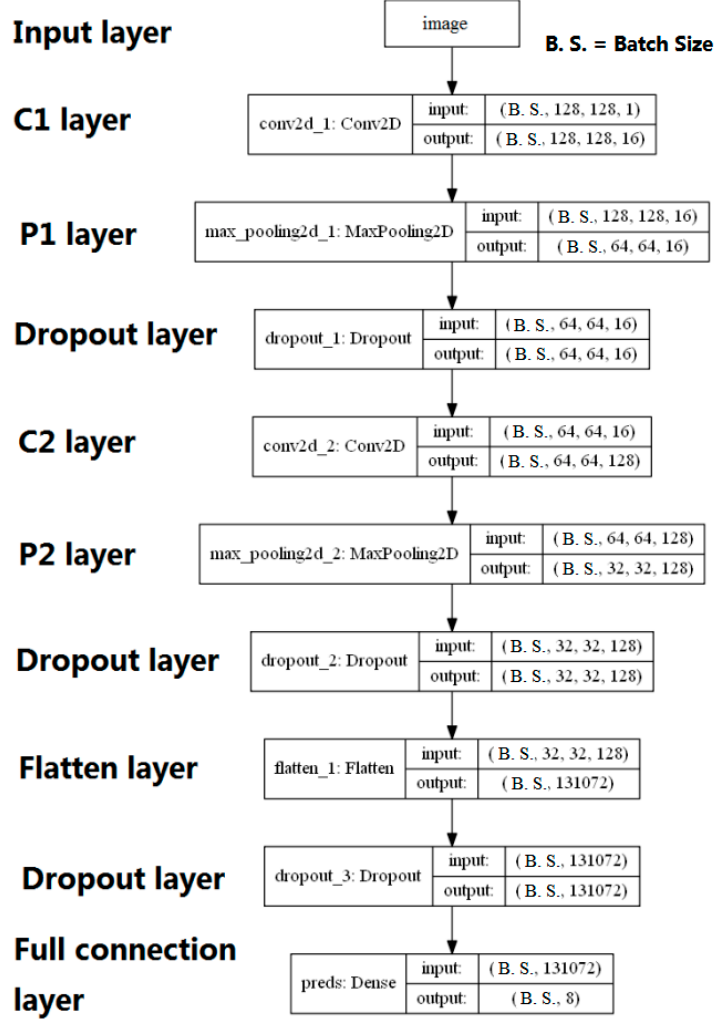
Figure 2. Architecture of the convolutional neural network (CNN). There are 10 layers in the network, among which only C1, C2, and full connection layers have learnable parameters. The batch size denotes the number of images sampled in one iteration, the other numbers indicate the size of the tensor input and output by each